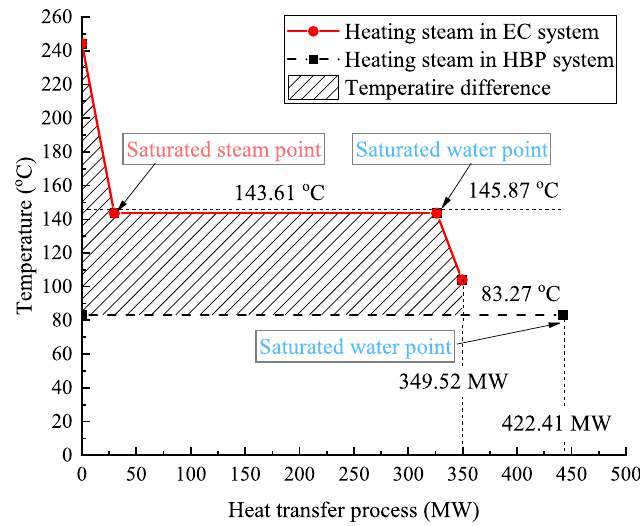
Figure 10. T – Q diagram of the heating